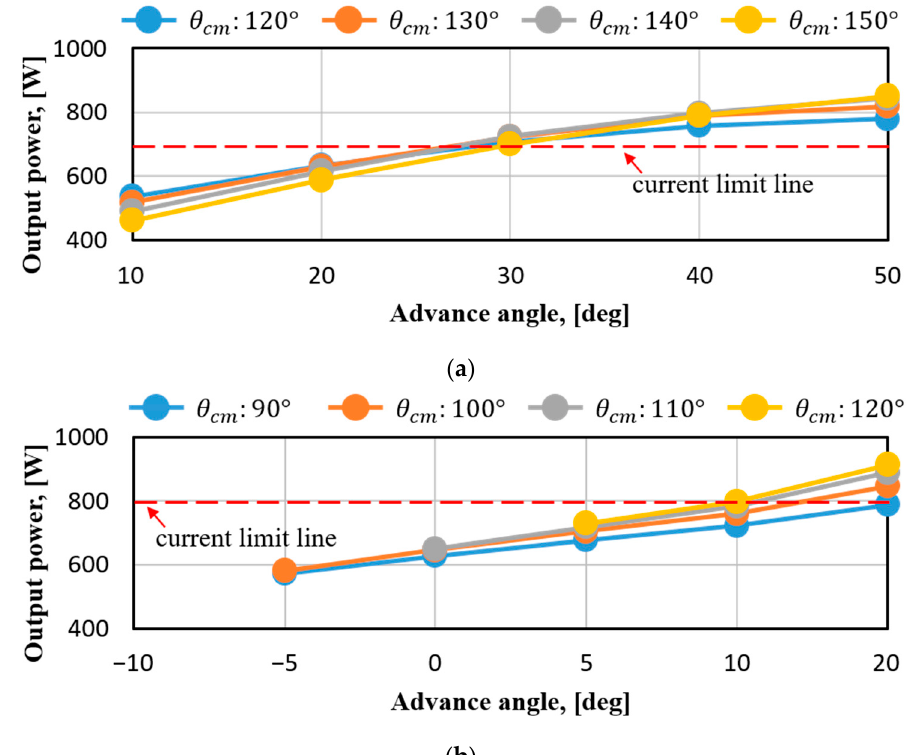
Figure 9. Output power of tapered air gap with respect to switching angles in the case of battery voltage: ( a ) 20V; ( b ) 26V.